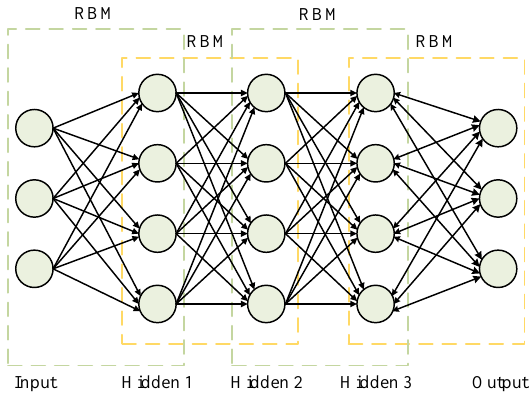
Figure 8. The DBN structure with the stacked